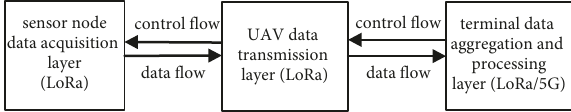
Figure 2: UAV-SREMS network